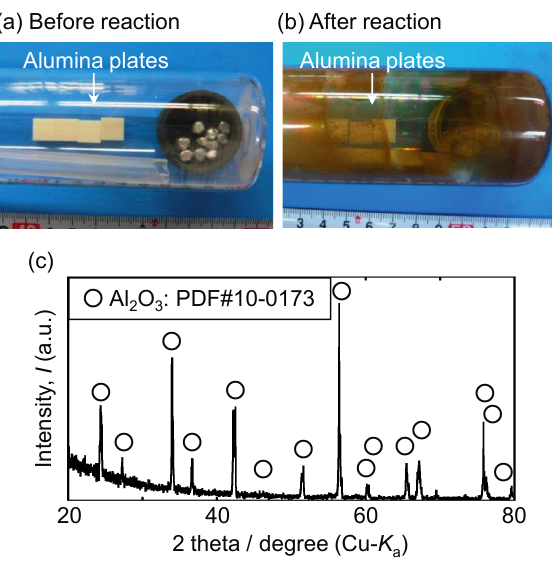
Figure 6. Photographs of the samples (a) before and (b) af- ter the reaction, and (c) XRD pattern of the alumina plates after the reaction in Exp.